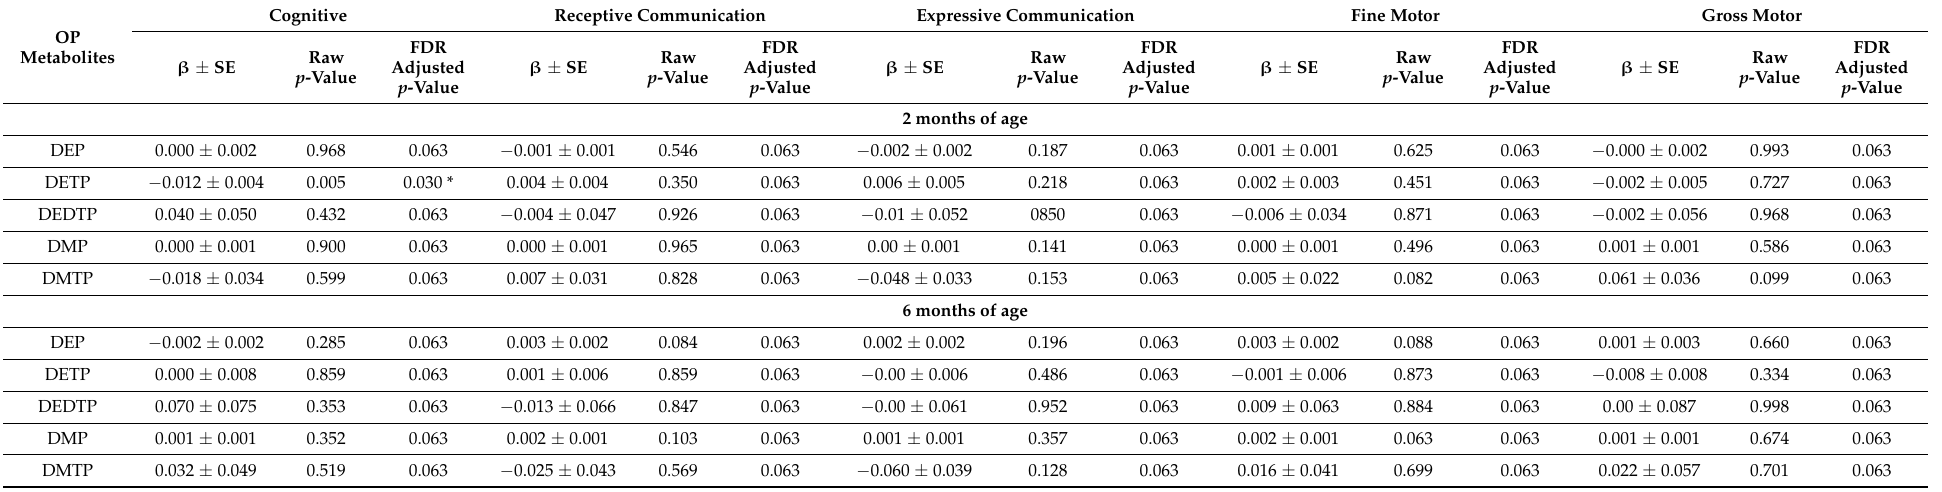
Table 5. Association between maternal urinary OP metabolites in the 1st–2nd trimester and infant developmental screening scores using the BSID–III screening test at 2 and 6 months of